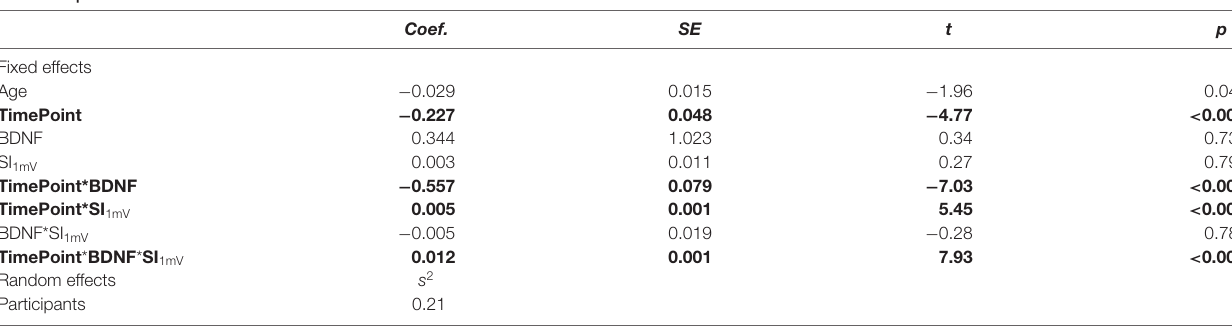
TABLE 3 | Mixed linear model coefficients and associated test